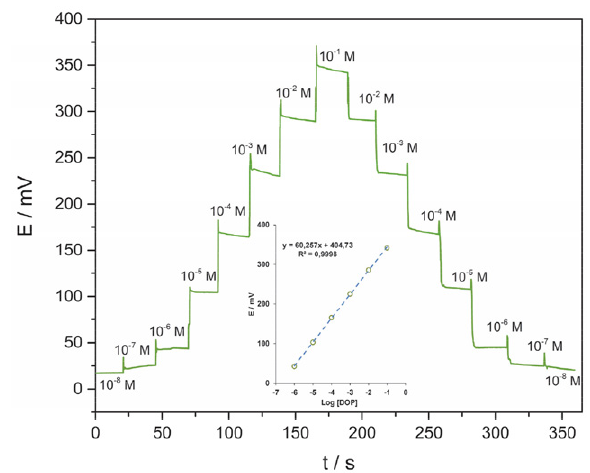
Figure 3. Potentiometric responses and calibration plot of the DOP-selective microsensor